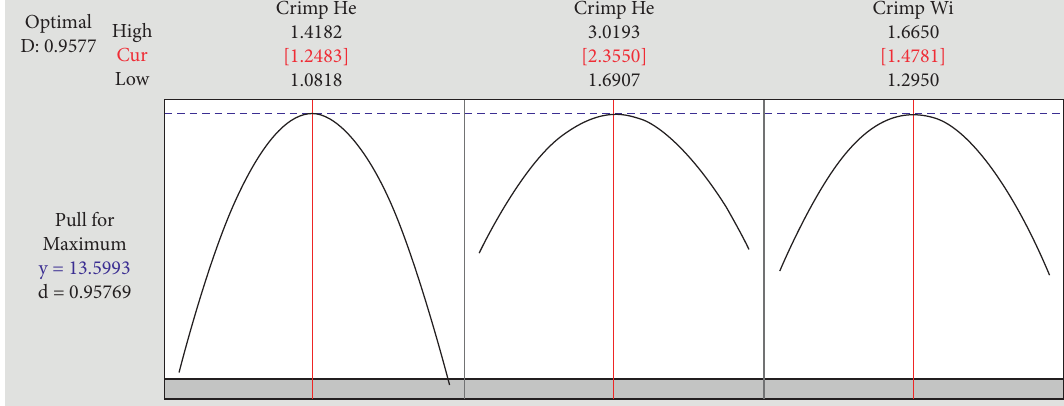
Figure 8: Optimum crimp parameters to sustain maximum impact pull force.